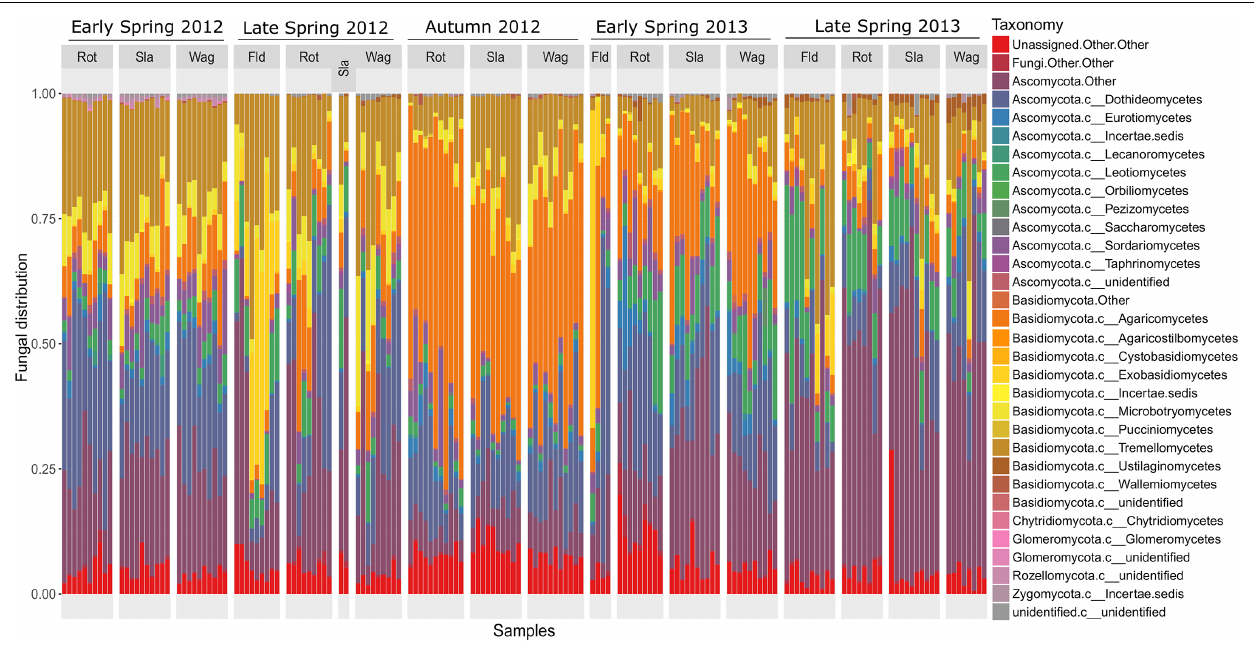
The amount of the plant pathogens P. striiformis , P.